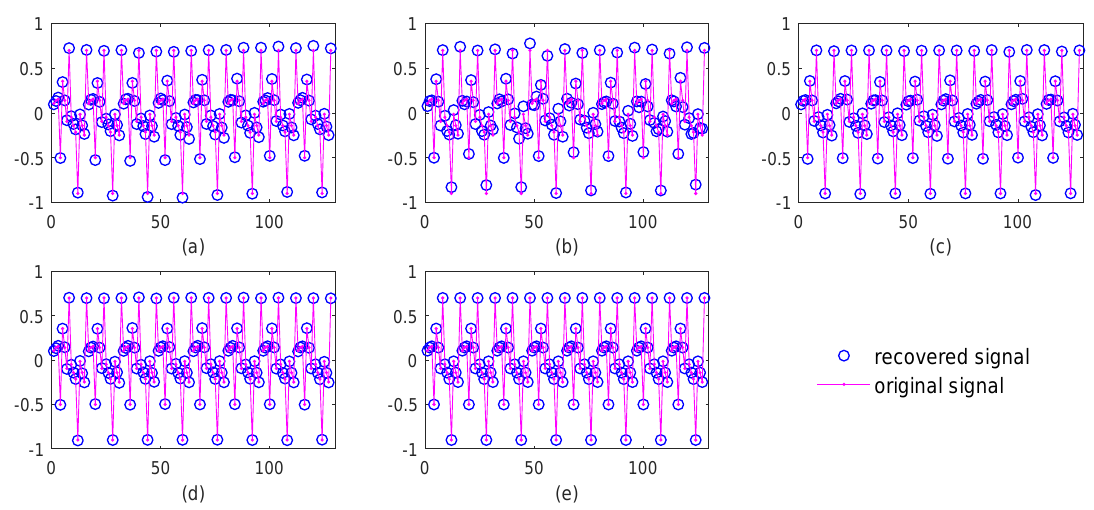
Figure 3. Signal recovery effect by BPDN, SL0, NSL0, L p -RLS, and weighted regularized smoothed L 0 -norm minimization (WReSL0) when noise intensity δ N = 0.2. ( a ) signal recovery by the BPDN algorithm; ( b ) signal recovery by the SL0 algorithm; ( c ) signal recovery by NSL0 algorithm; ( d ) signal recovery by the L p -RLS algorithm; ( e ) signal recovery by the WReSL0 algorithm.